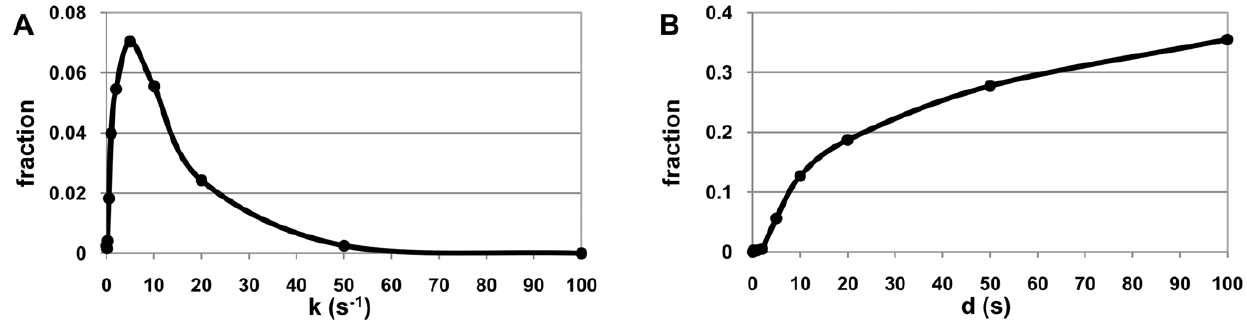
Figure 2. Pausing and the fraction of microbursts. Fraction of two or more consecutive RNAs produced within an interval smaller than 5 seconds for various values of (A) pausing rate (k pause ) and, (B) pause duration (d pause ). Note the different scales in the y-axis in 2A and